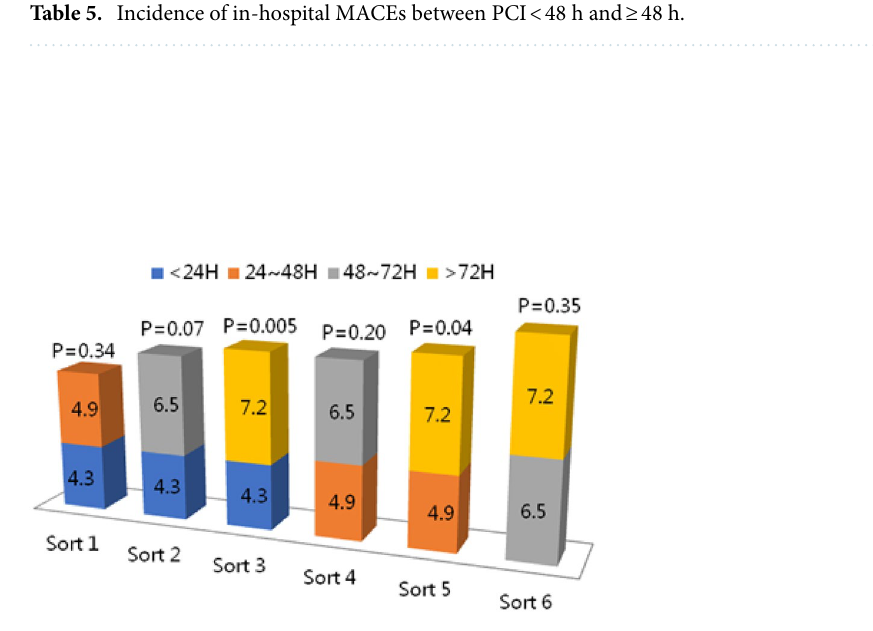
Figure 1. Comparison of MACE event rates among groups. Different interventional times affect MACE event rates. Sort 2, Sort 3 and Sort 5 showed significant differences (P = 0.07, 0.005, 0.04). Others showed nonsignificant difference (P >